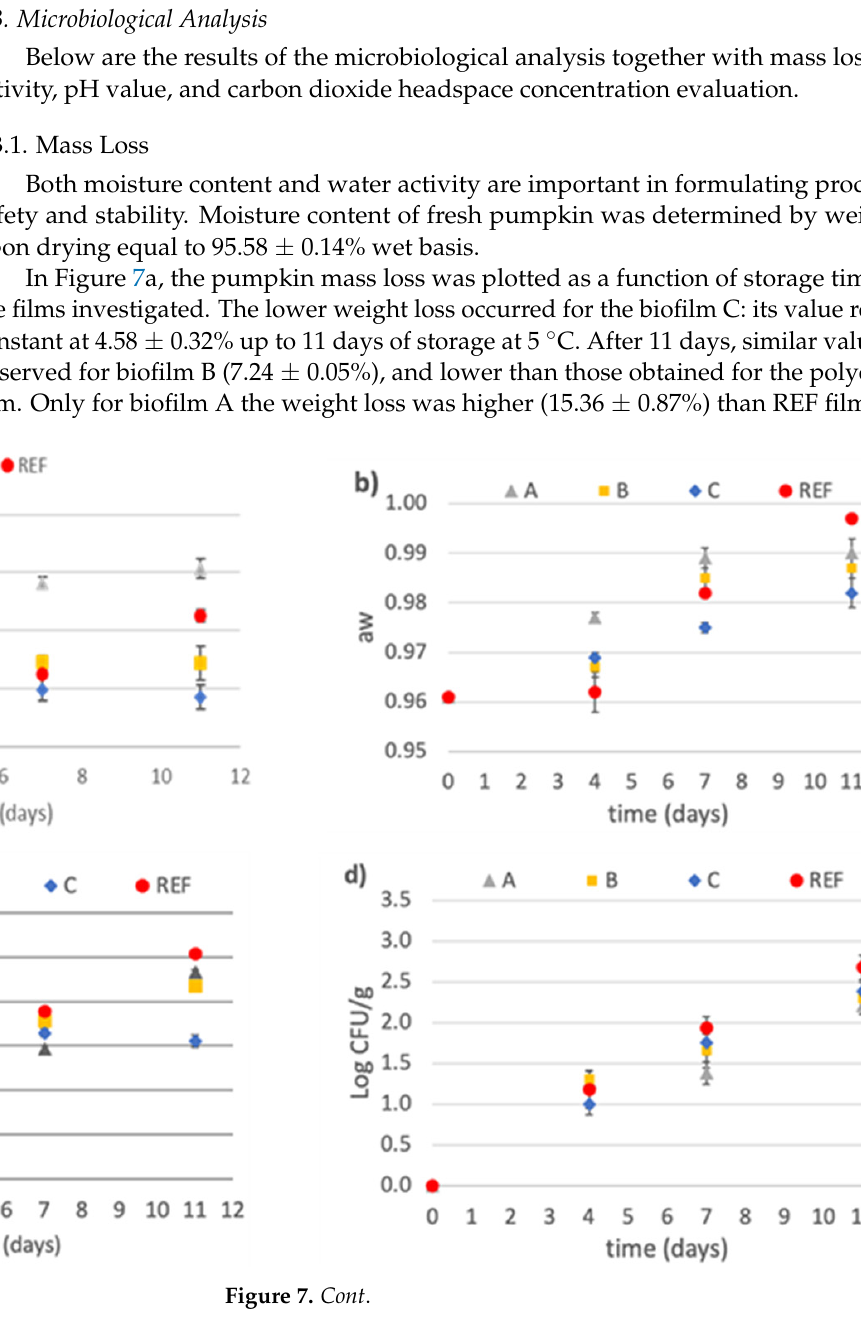
Figure 7. ( a ) Mass loss percentage, ( b ) water activity (a w ), ( c ) total microbial count, ( d ) lactic acid bacteria load, ( e ) yeasts and molds count, and ( f ) pH evaluated in fresh and packaged pumpkin samples, during shelf-life; ( g ) carbon dioxide concentration in headspace of pumpkin package in different films. REF: Polyethylene film; commercial biofilms: A, B and C .